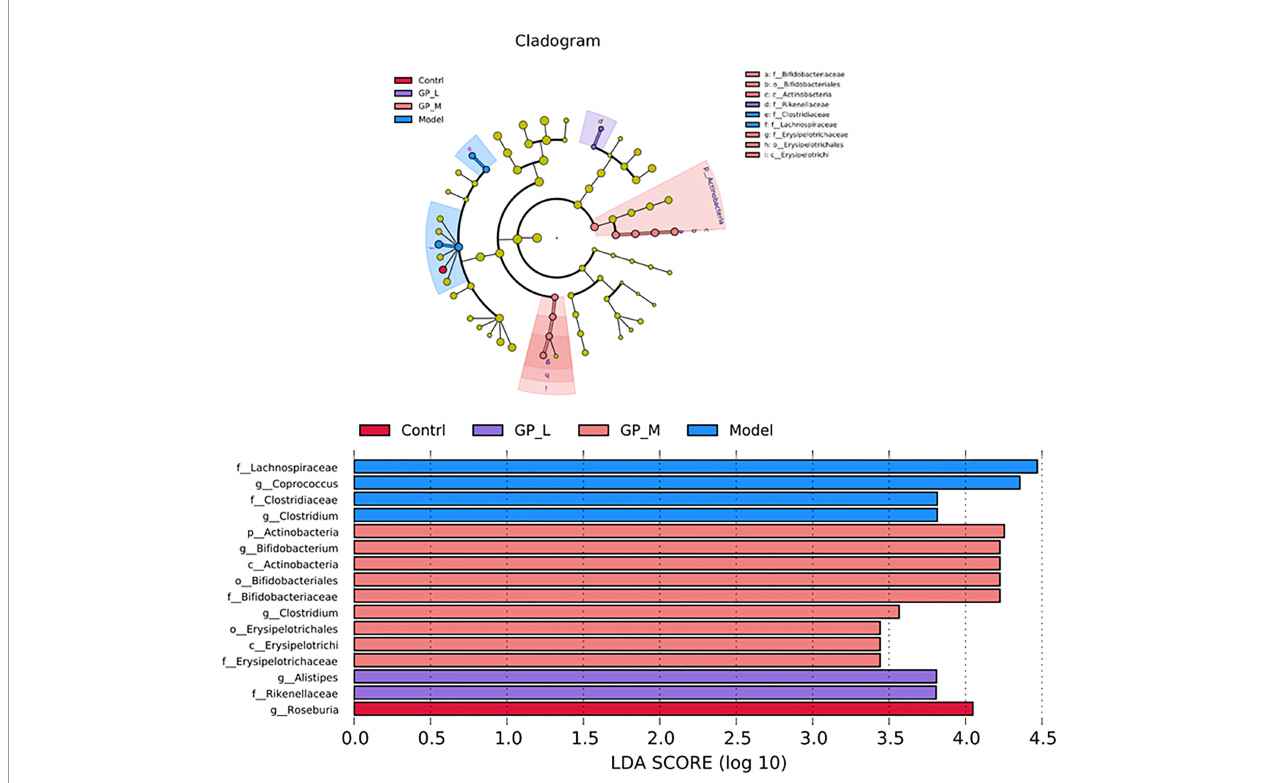
FIGURE 8 | Cladogram map of LEfSe analysis on Genus and Bar chart of LEfSe